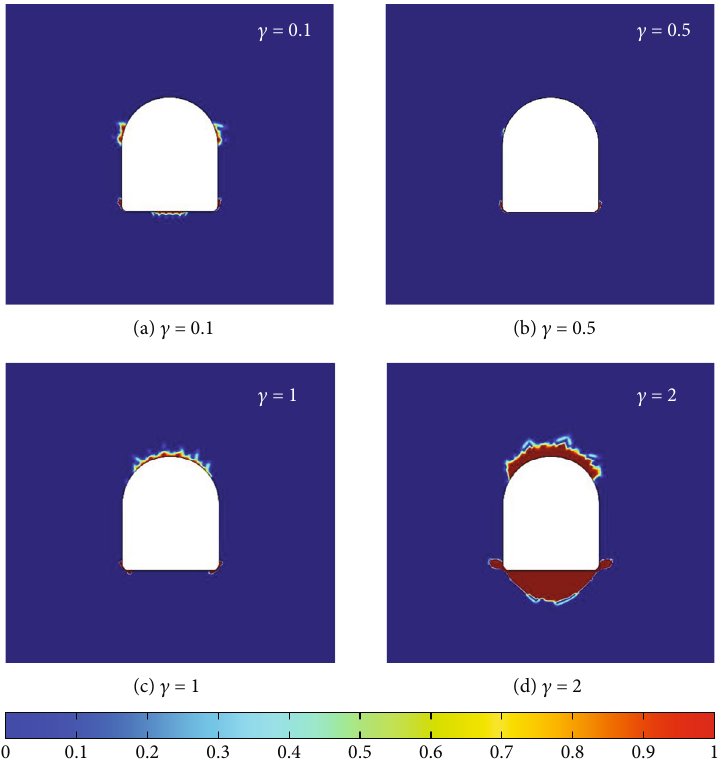
Figure 11: The damage evolution of rock mass of karst